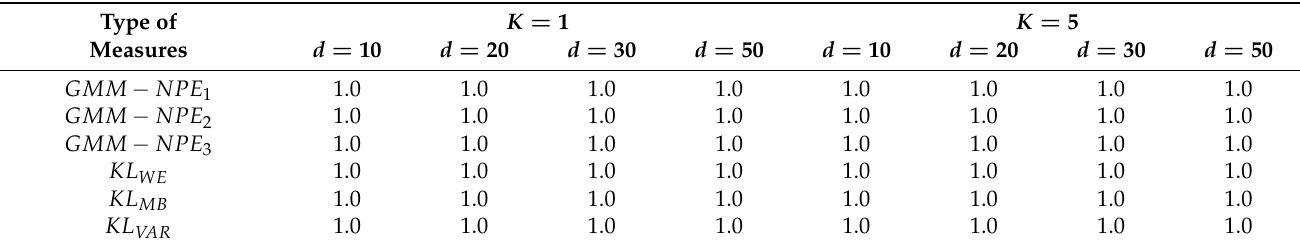
Table 8. Results in the form of recognition accuracy, obtained on the synthetic data: l = 2, t 1 , t 2 ∈ [ 0,5 ] , N = 800, M = 200, m 1 = 0, m 2 = 10 h , with h = [ h 1 , . . . , h d ] T , h i ∼ U ([ 0,1 ]) , i = 1, . . . , d . Type